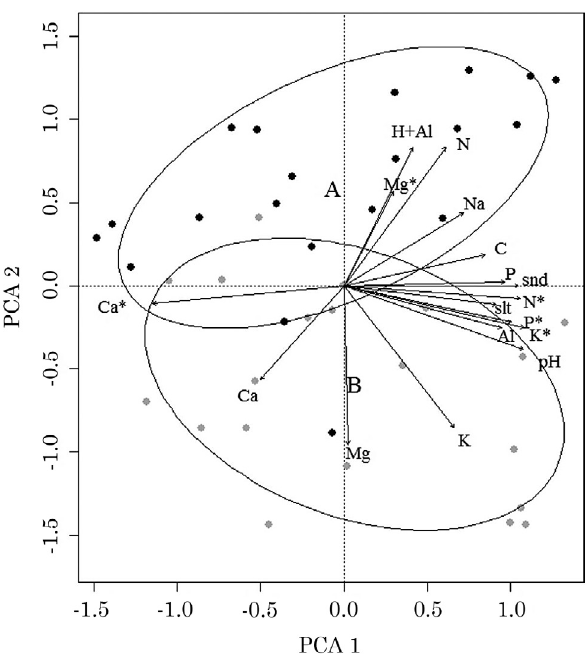
0.46 Figure 2. Final PCA configuration showing sampling